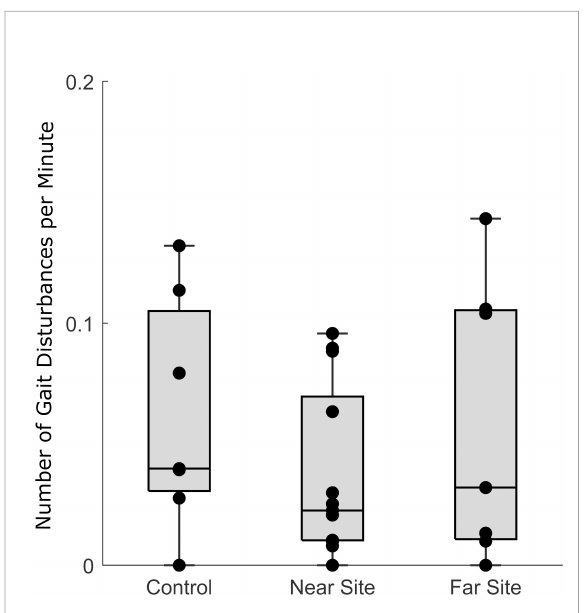
FIGURE 6 The number of daily gait disturbances calculated from kinematic algorithms trained by con fi rmed reactions. Although squid reacted to pile driving noise, it did not signi fi cantly increase the number of total gait disturbances over an experimental